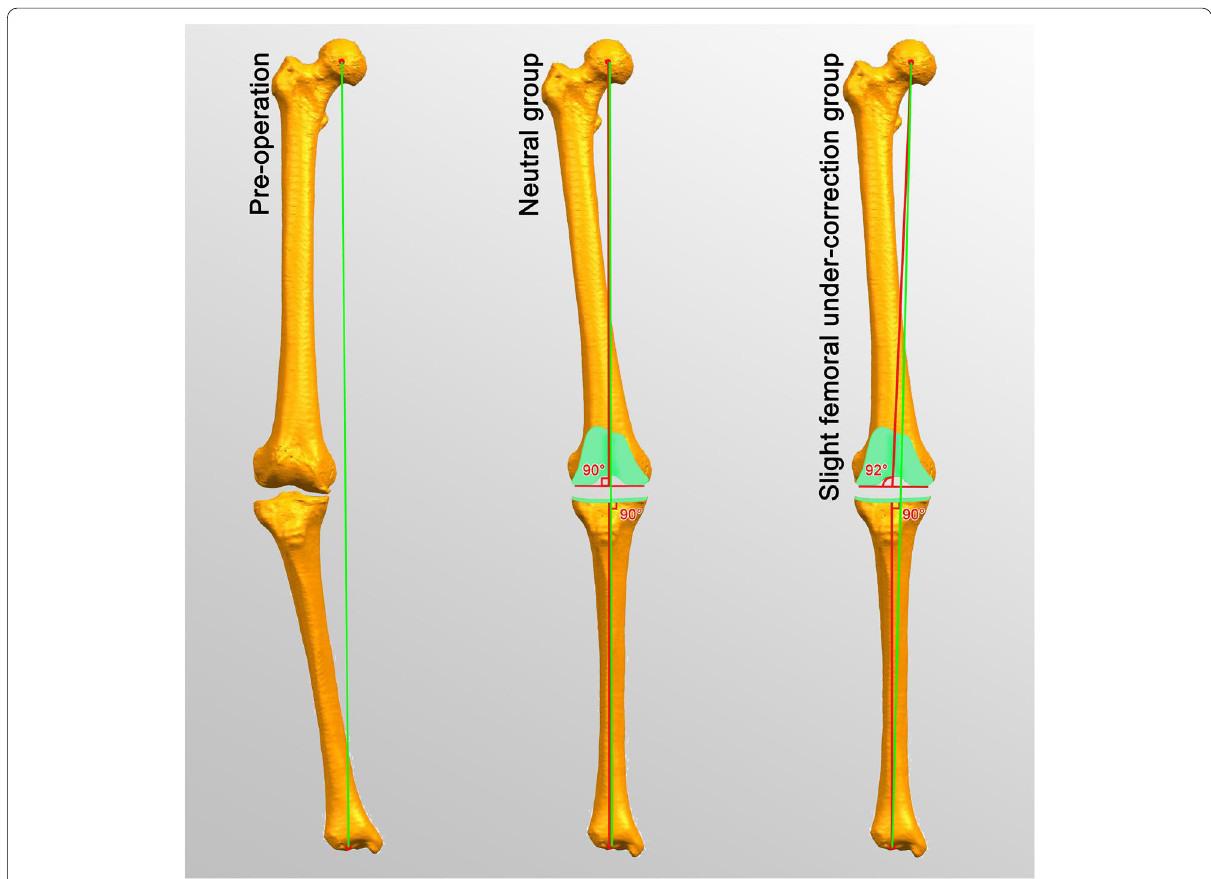
Fig. 1 Comparison of alignment targets between two